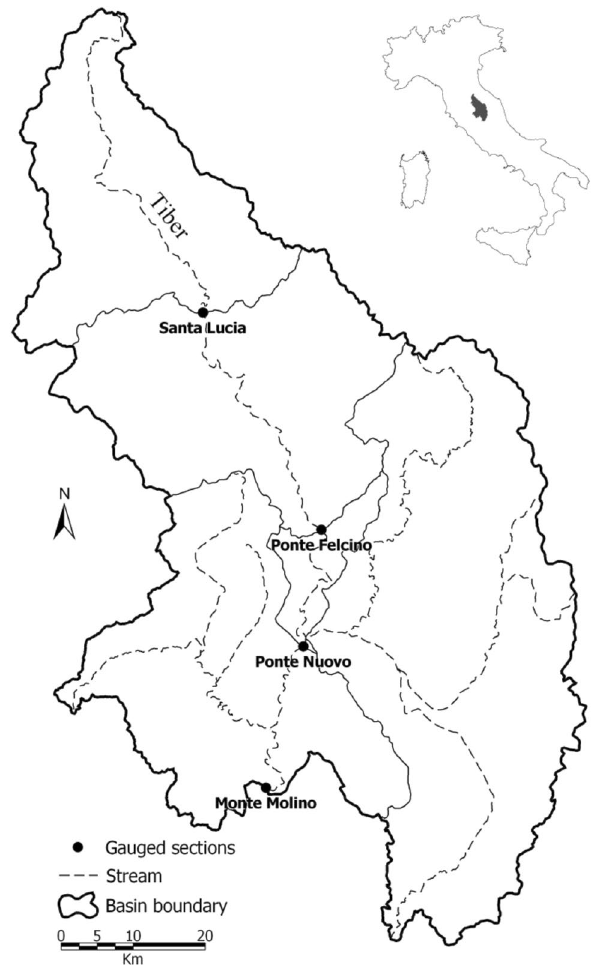
Fig. 1 Gauging stations and river reaches in Tiber River